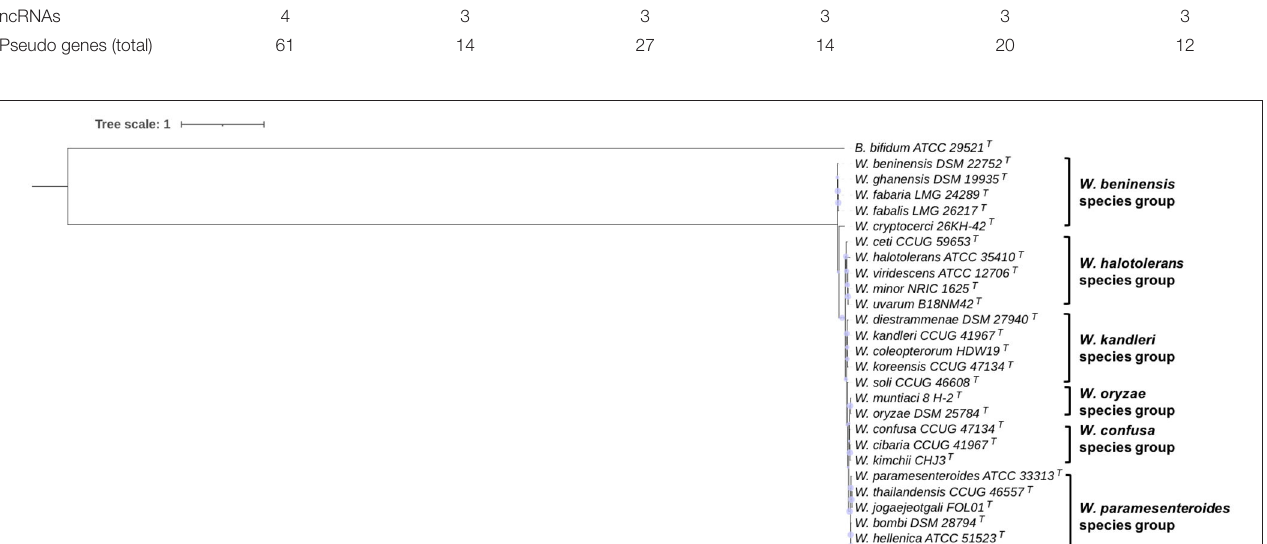
FIGURE 1 | 16S rRNA gene-based phylogeny of Weissella species. Phylogeny was performed using the neighbor-joining method; phylogenetic robustness was inferred by a bootstrapping procedure from 500 replications to obtain the confidence value for the aligned sequence dataset. Bifidobacterium bifidum ATCC 29521 T